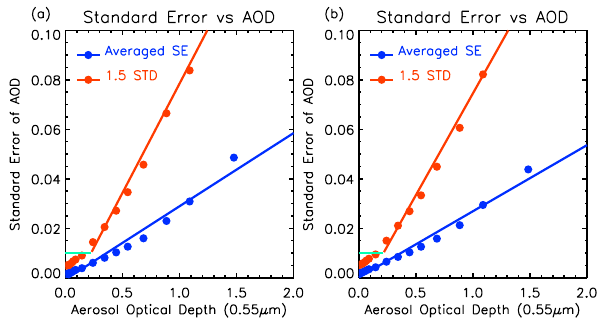
Fig. 2. Scatter plot of standard error threshold of AOD versus AOD at 0.55µm. Dots represent the averaged Standard Error (blue) of AOD and the 1.5 standard deviation (red) for every 0.05 of AOD when AOD < 0.5 and 0.3 of AOD when AOD > 0.5. In small AOD cases, light blue lines show the cutoff of 0.01 in standard error. The blue lines and red lines (for AOD > 0.2 only) show the linear fit of corresponding dots. (a) for C5 Aqua MODIS AOD. (b) for C5 Terra MODIS